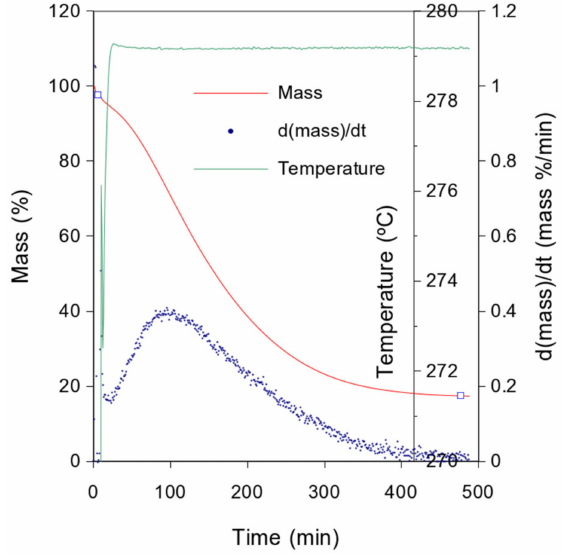
Figure 2. Plots of the TG and DTG curves obtained in an isothermal experiment at 279 ◦ C. The points chosen for estimating the mass loss involved in the main degradation process are marked as squares on the mass % curve.